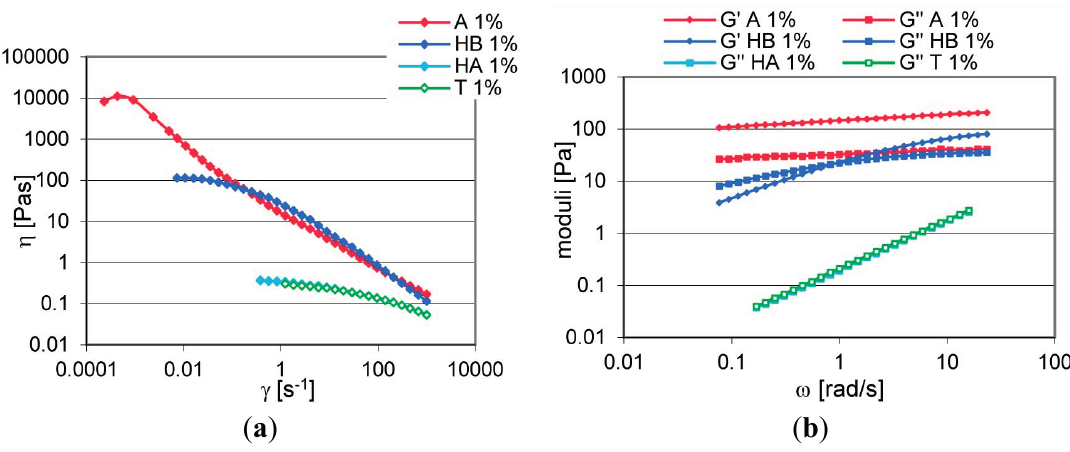
Figure 7. ( a ) Viscosity trends vs. the shear rate; ( b ) G’ and G’’ trends as a function of frequency of A, HB, HA and TSP (1% w / w